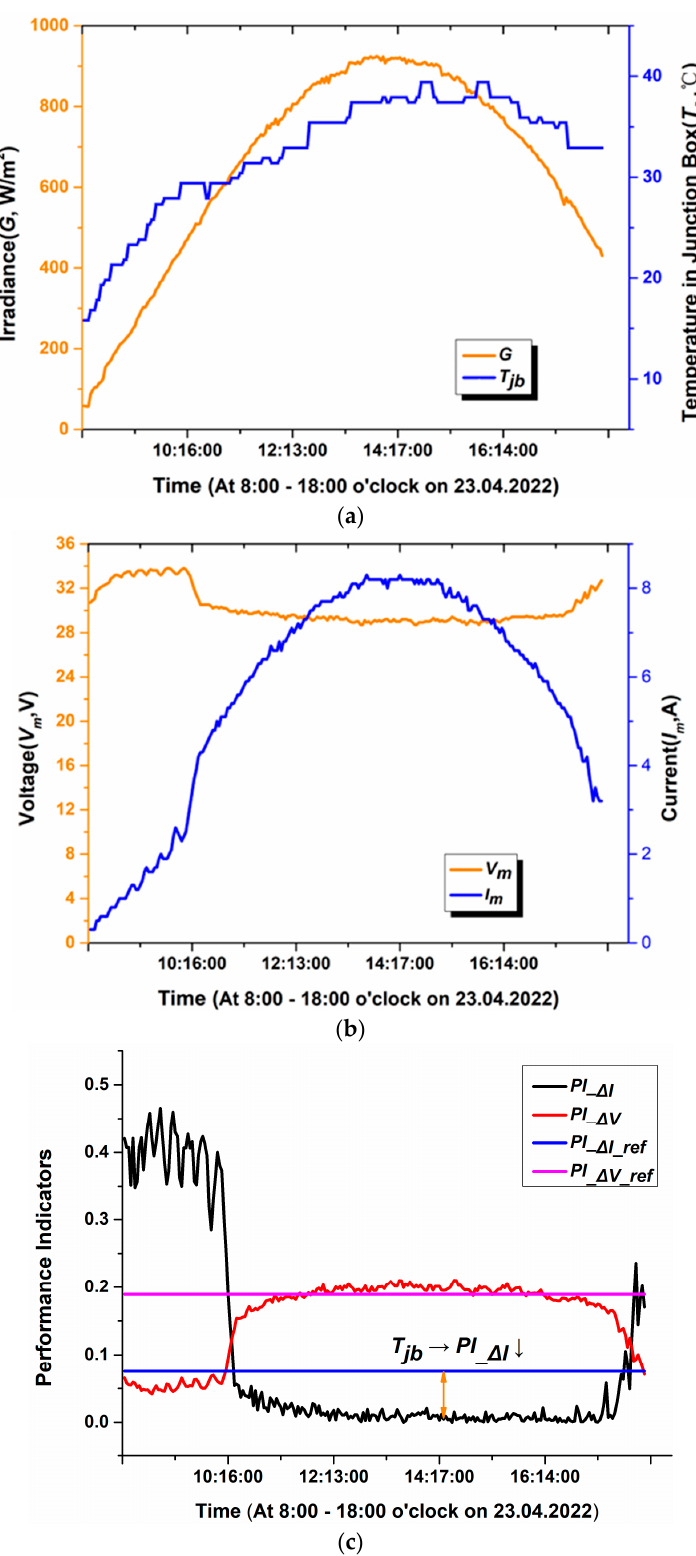
Figure 5. Calculated performance indicators through T jb on a day: ( a ) Irradiance and temperature inside the junction box; ( b ) Voltage and current at MPP; ( c ) Performance indicators through T jb